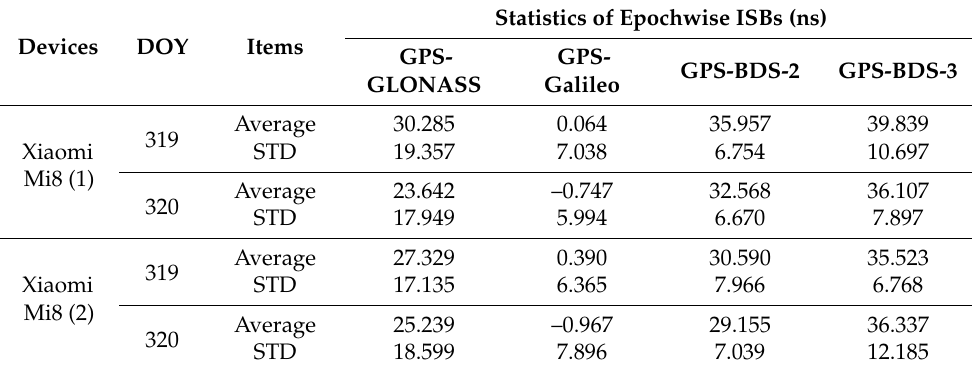
Figure 16. Epochwise ISB estimates for two smartphones on DOY 319 and 320 of 2020. Table 7. Average value and STD of epochwise ISBs for two smartphones.